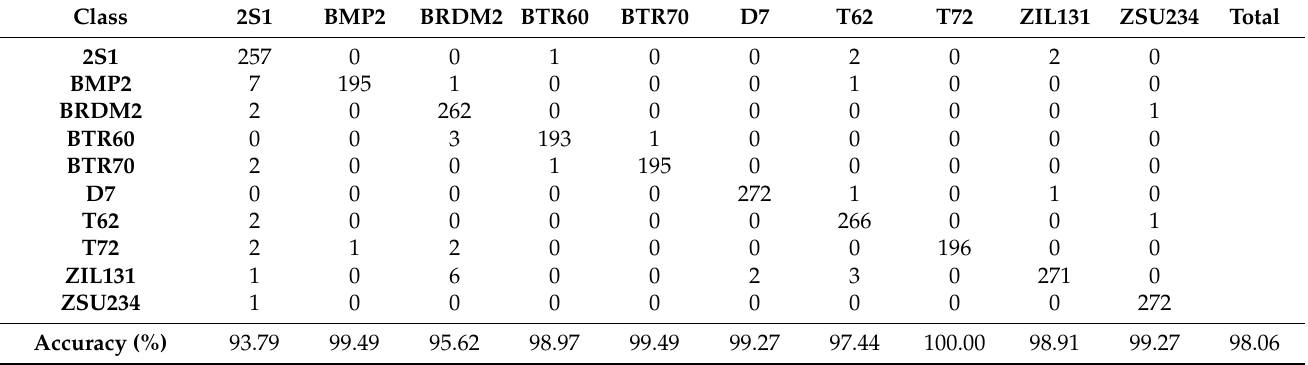
Table 6. Confusion matrix of the amplitude–real–imaginary CNN based on sparse images under